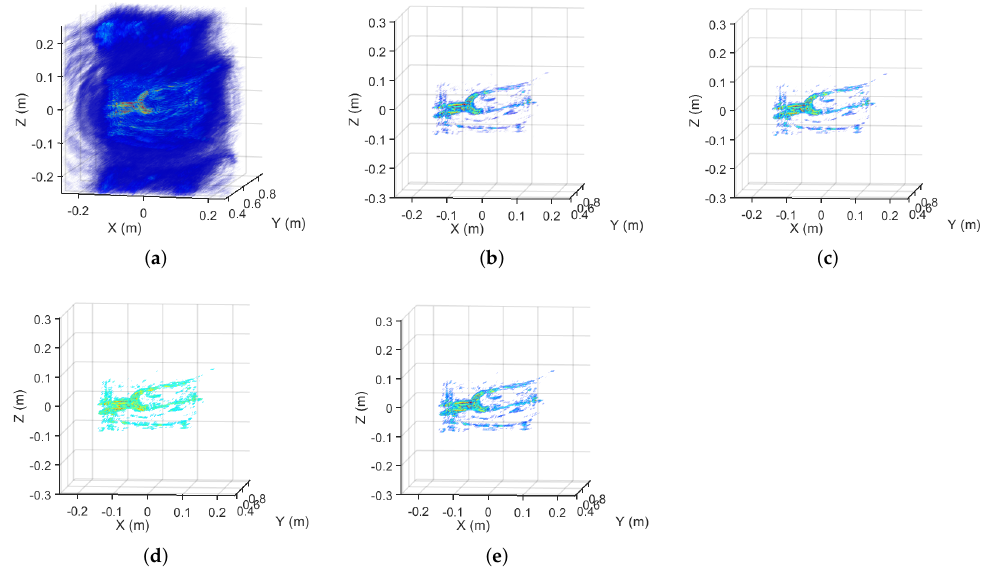
Figure 9. The imaging results of real complex target SAR data corresponding to the 100% sampling rate. ( a ) The MF result. ( b ) The MM- L 1 result. ( c ) The MM- L 1/2 result. ( d ) The MM- L 0 result. ( e ) The GMM- L 0.8 result.